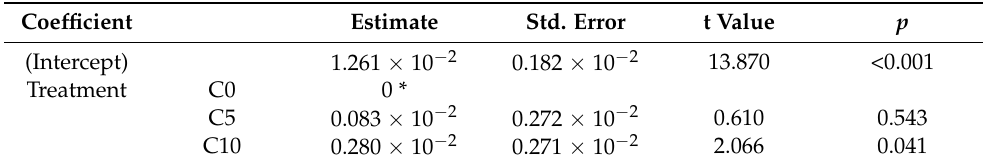
Figure 1. Size-dependent growth rate (annual biomass increments; a – c ) and relative growth rate of the dbh ( d – f ) of all tree stems (dbh > 5 cm) in C0 (control), C5 (5 Mg ha − 1 ), and C10 (10 Mg ha − 1 ) treatments after biochar application to an oak ( Q. serrata ) forest. Table 2. Summary of the results of a LMM to examine the difference in the relative growth rates of the dbh (RGR d ) of canopy oak trees (dbh > 20 cm) across treatments (C0, C5, and C10). The fixed effect of the control (C0) was set to zero